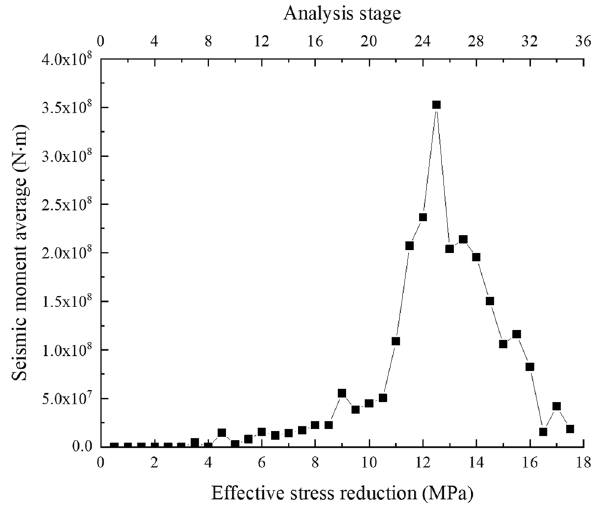
Fig. 13 Average of seismic moment for each analysis stage